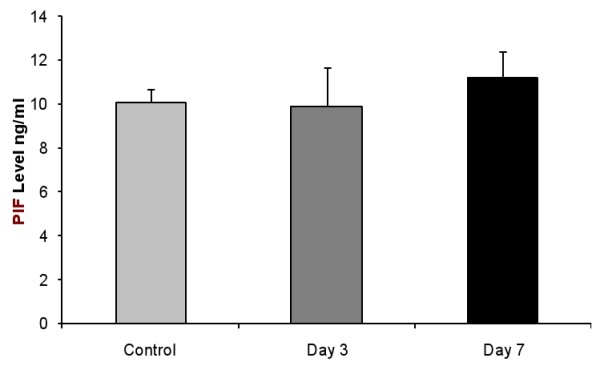
PIF levels in atretic embryos are similar to non-cleaving embryos. The medium collected from embryos that failed to progress from day 3 to day 7 of culture were analyzed sequentially and levels Mean+/-SEM were compared with non-cleaving embryos. There were no significant differences among the groups tested (n = 5-15/group).